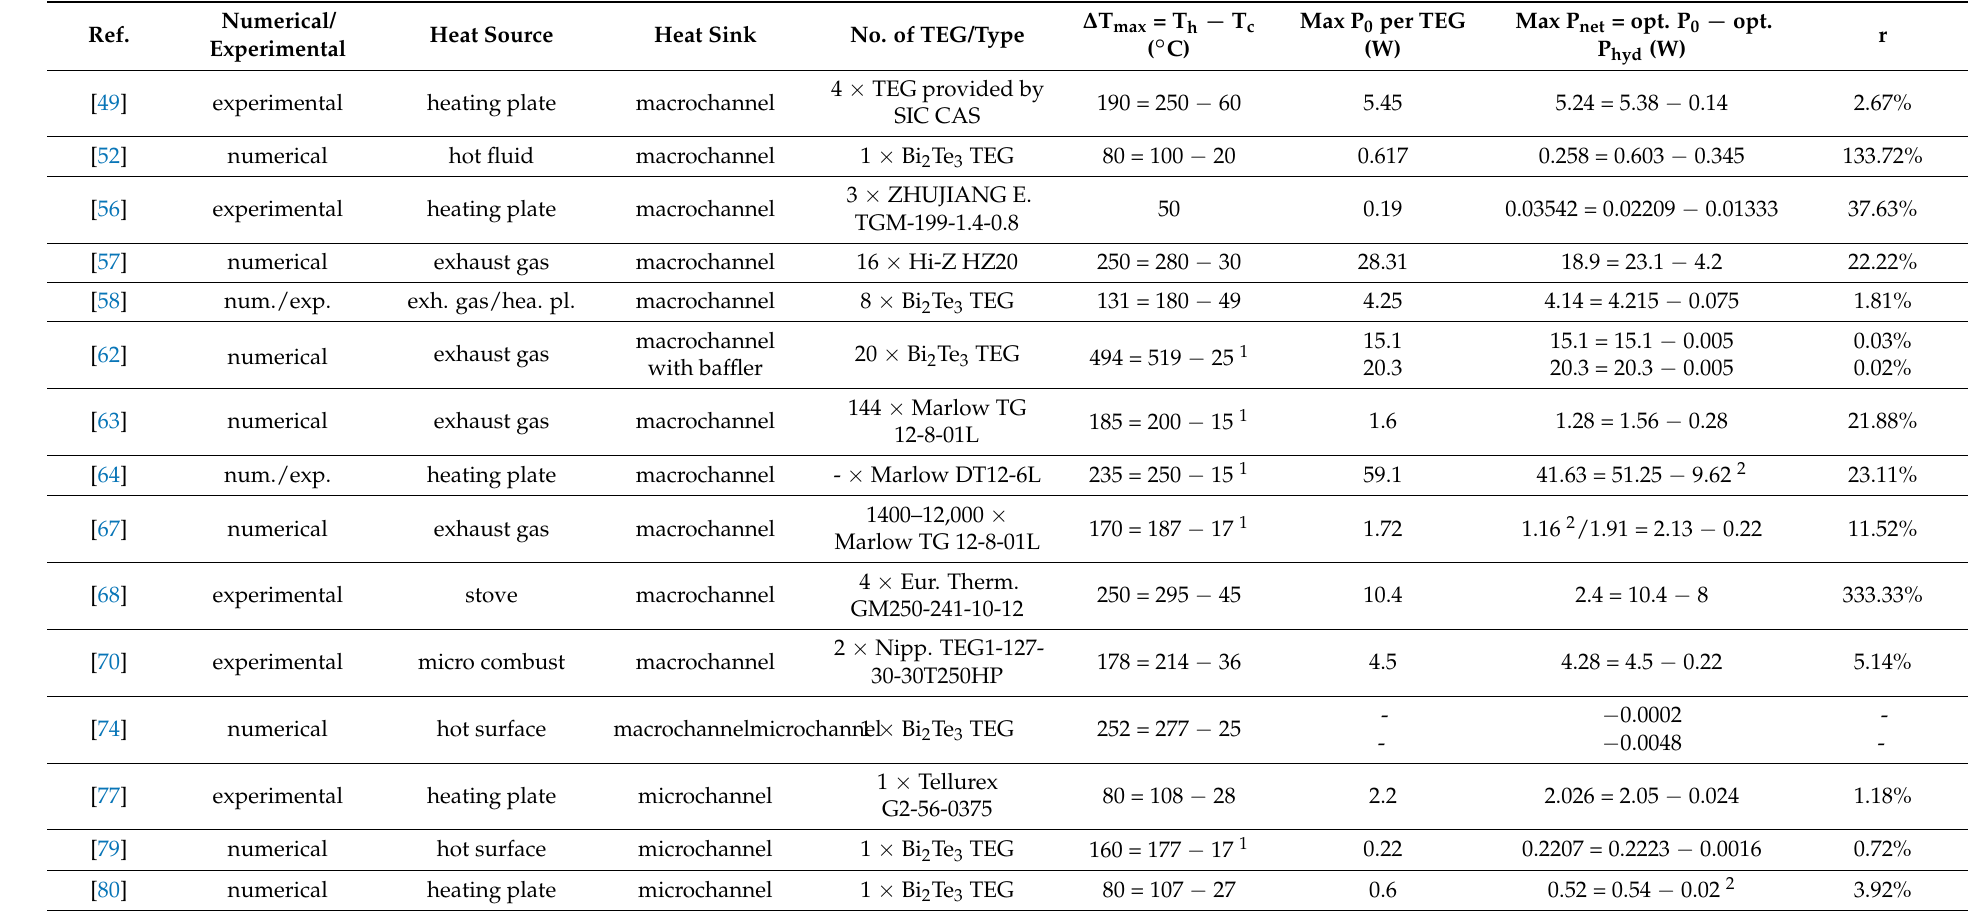
Table 1. Comparison of different TEG systems in whose investigation the net output power is considered. Please note that the values are often read from the published graphs, so there may be small